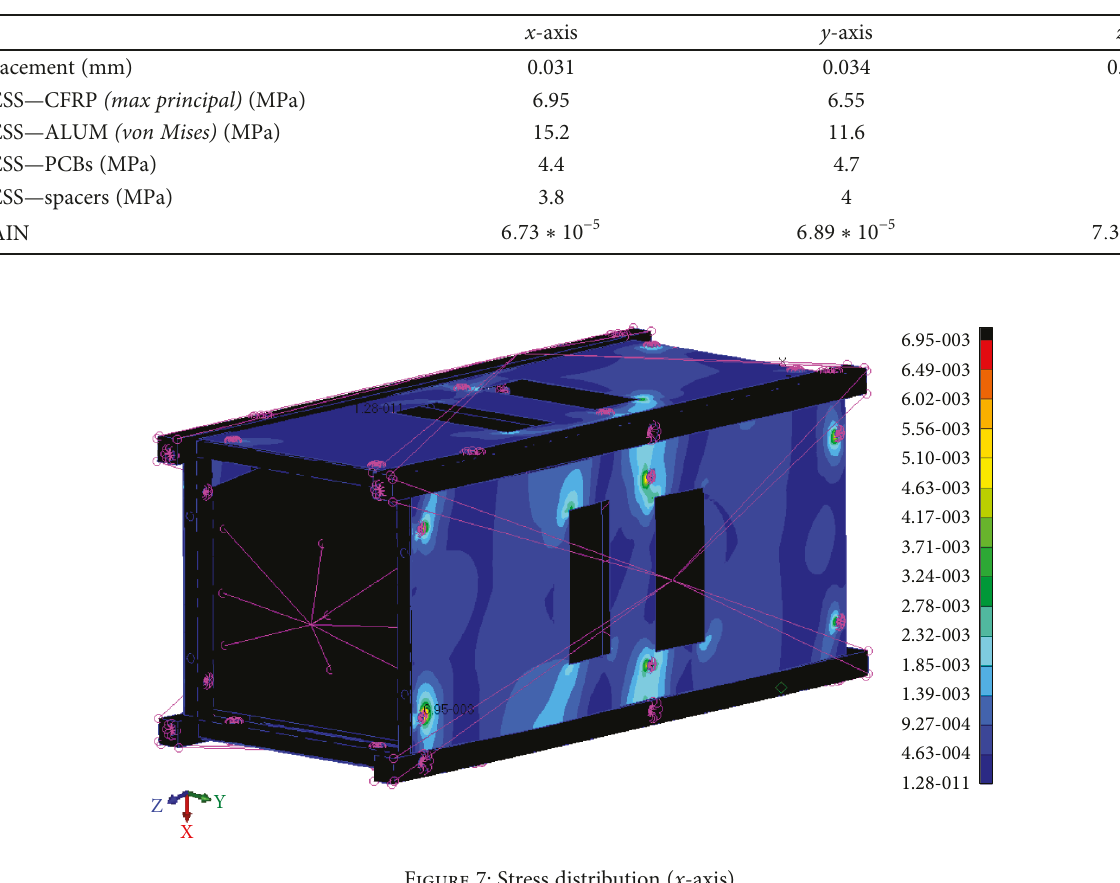
Figure 6: The fi rst 4 eigenfrequencies and mode shapes for “ hybrid ” UPSat. Table 3: Quasistatic analysis results.